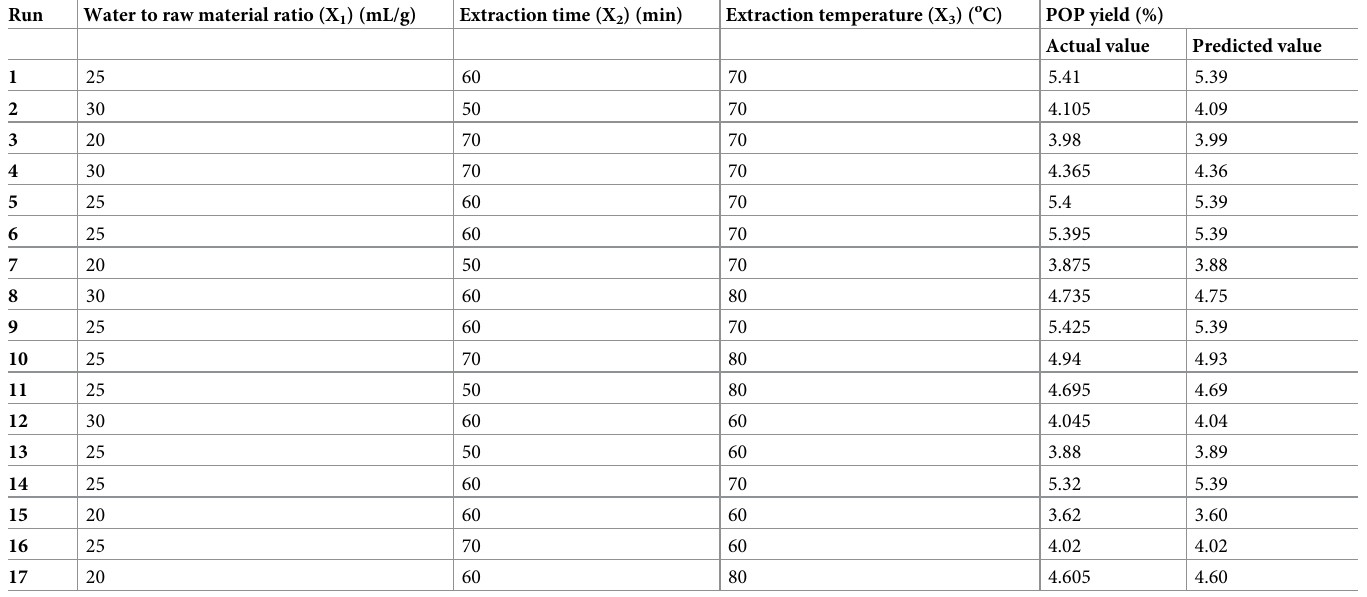
Table 1. Box-Behnken experiment design and the results of the POP yield. Run Water to raw material ratio (X 1 )